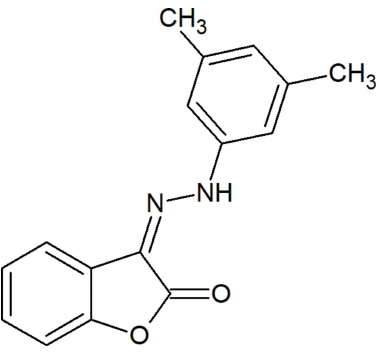
Table 1 Hydrogen-bond geometry (A˚ , (cid:3) ).